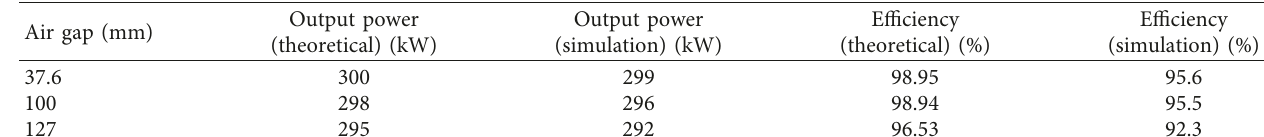
Table 3: Output power and efficiency under air gap fluctuation.